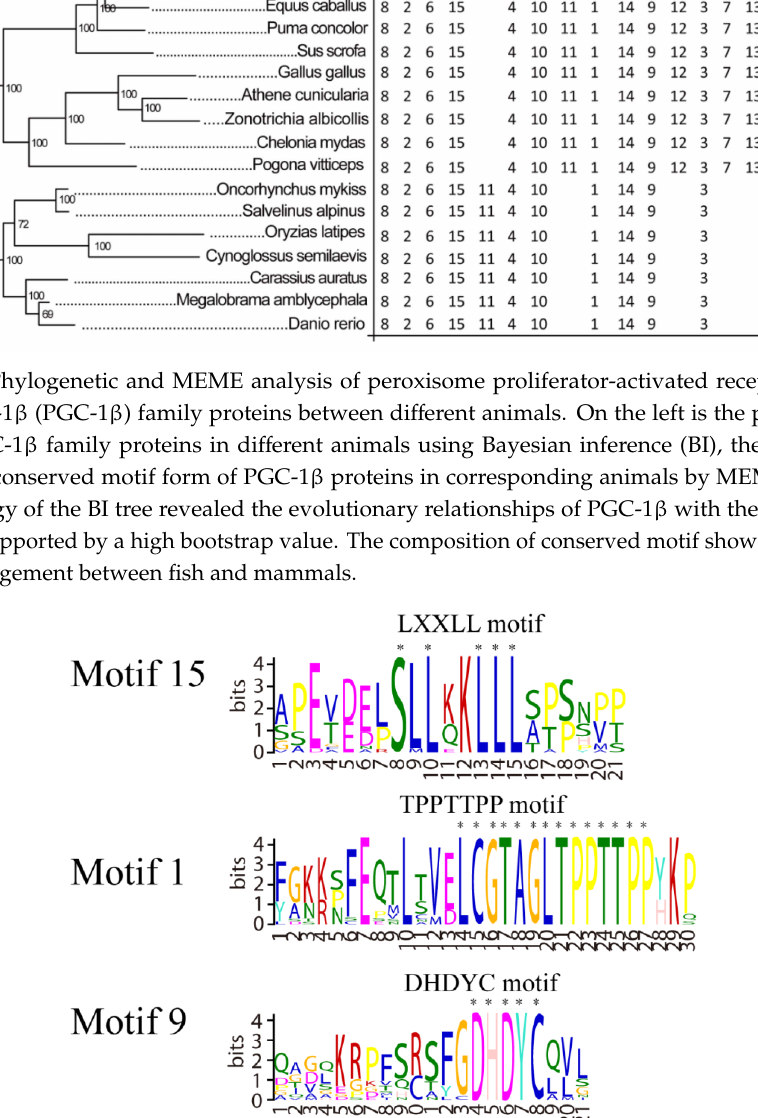
Figure 2. The conserved motif of PGC-1 β family proteins in fish and mammals. MEME results showed that there are three conserved motifs (LXXLL, TPPTTPP, and DHDYC) in fish and mammals. X means any amino acid residue and the letter size indicates different conservation. The functions of these domains are as following: LXXLL motif plays a crucial role in the interactions between the coactivators and liganded nuclear receptors, TPPTTPP motif can bind to PPAR δ or phosphorylation, DHDYC motif is the putative binding site of host cell factor 1 (HCF1).